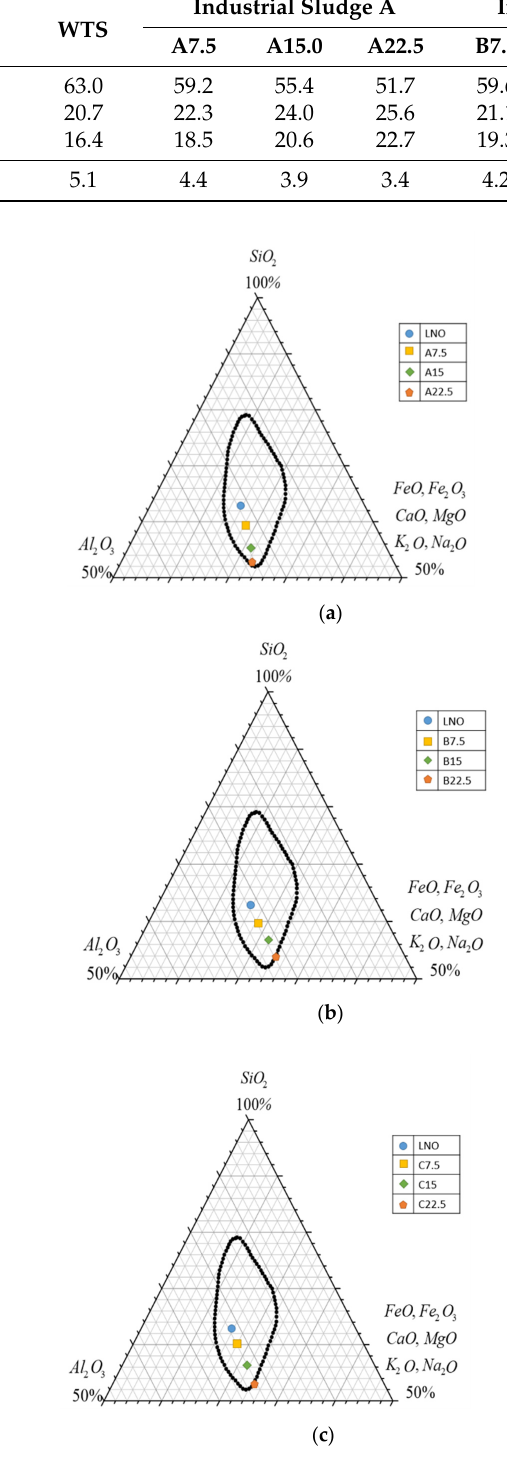
Figure 2. Ternary phase diagram of water treatment sludge mixed with ( a ) Industrial Sludge A, ( b ) Industrial Sludge B, and ( c ) Industrial Sludge